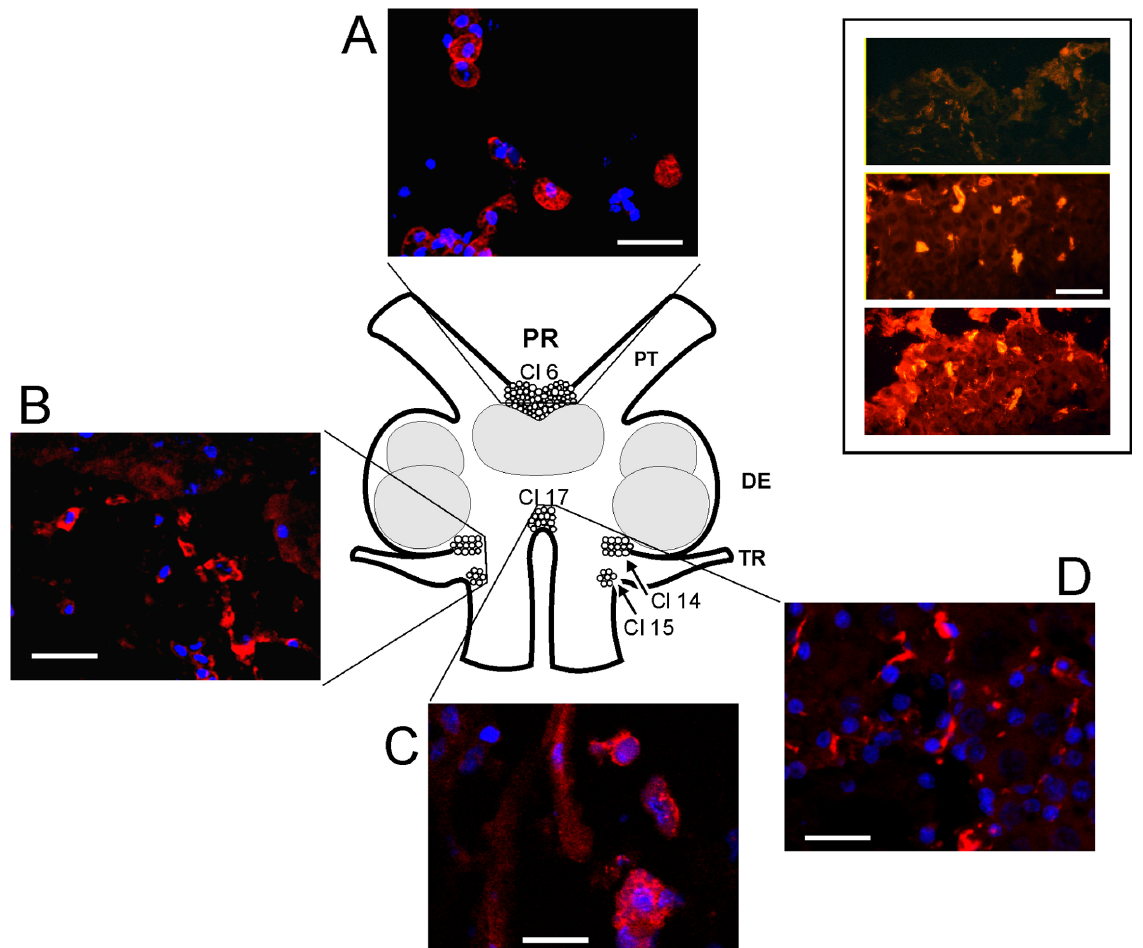
Figure 3. Confocal images showing brain CHH-positive cells and fibers. Immunohistochemical localization of CHH-IR cells in the crayfish brain. The drawing represents a dorsal view of the brain as they relate to the representative confocal 1.6 m m optical sections stacked in 10 m m images of CHH-IR in the neuronal clusters (Cl 6, Cl 14,15 and 17). CHH is marked in red, and the cell nucleus marked in blue (DAPI). PR, protocerebrum; DE, deuterocerebrum; TR, tritocerebrum; PT, protocerebral tract. The white calibration bars equal 40 m m. The inset shows three horizontal serial sections of PR from the dorsal (upper panel) to central (lower panel) brain (CHH is shown in red). Immunopositivity is visible in all of the sections and is brighter in the central section. White calibration bar=100 m m.